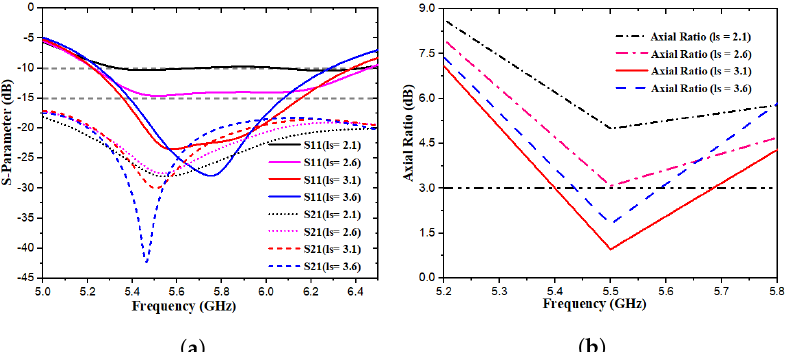
Figure 7. ( a ) S-parameters of different plots for patches, corner cut length and width ls . ( b ) Axial ratio of different plots for patches, corner cut length and width ls